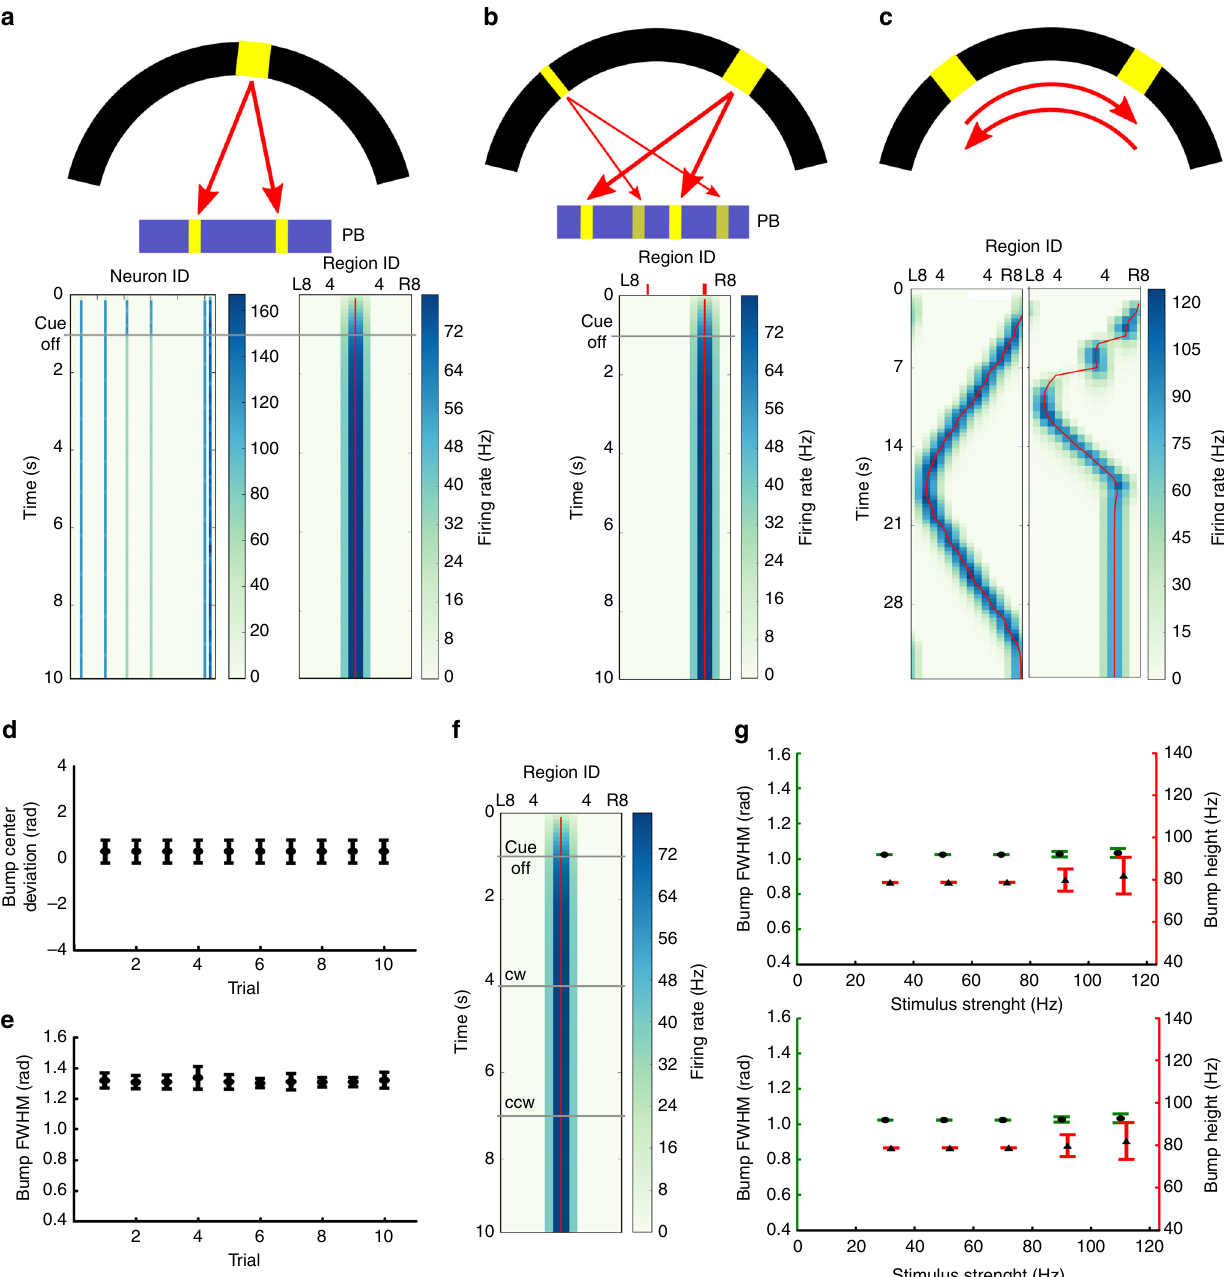
Fig. 3 Persistent activity bump in the C-ring. a Top : A visual cue ( yellow bar in the black visual fi eld ) is modeled by the spike input to two corresponding PB regions (see Methods). Bottom left : The visual cue elicited fi ring activity (represented by graded cyan ) in several neurons and the responses persisted after the cue offset. Bottom right : A stable activity bump can be observed in the EB region-based fi ring rate plot. The red line is the estimated center of the activity bump, determined by the peak position of the Gaussian curve fi t to the activity bump in each time step. b When we presented two visual stimuli with different brightnesses ( top ), the C-ring circuit developed only one activity bump in the EB ( bottom ) due to the nature of the neural competition. The thick and thin red ticks mark the EB regions corresponding to the stronger and weaker visual cues, respectively. c We investigated the response of the C-ring to a visual cue that moves across the visual fi eld ( top ). Bottom left : the cue fi rst moved clockwise for 16 s with a speed of 22.5° s − 1 and then reversed direction. Bottom right : the cue moved with a double speed for 8 s in each direction and then stopped. The circuit was able to accurately track the moving visual cue at a speed of 22.5° s − 1 . The quality of the activity bump and its ability to track the moving cue (at 22.5°s − 1 ) are indicated by d the deviation between the bump center and the cue location, and by e the bump width (FWHM). The error bars indicate the within-trial s.d. f The activity bump is stable and does not shift in the dark during simulated body rotation (CW = clockwise, CCW = counterclockwise). g The height ( red ) and width (FWHM) ( green ) of the bump following stimulus offset were independent of the strength ( top ) and duration ( bottom ) of the stimulus, suggesting that the activity bump only encodes the direction of the stimulus, not its other non-spatial properties. Each data point was averaged over 10 trials and the error bars indicate